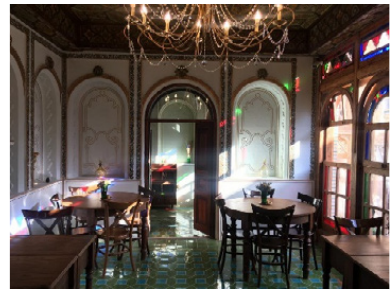
Fig 4: Harmony of light and color